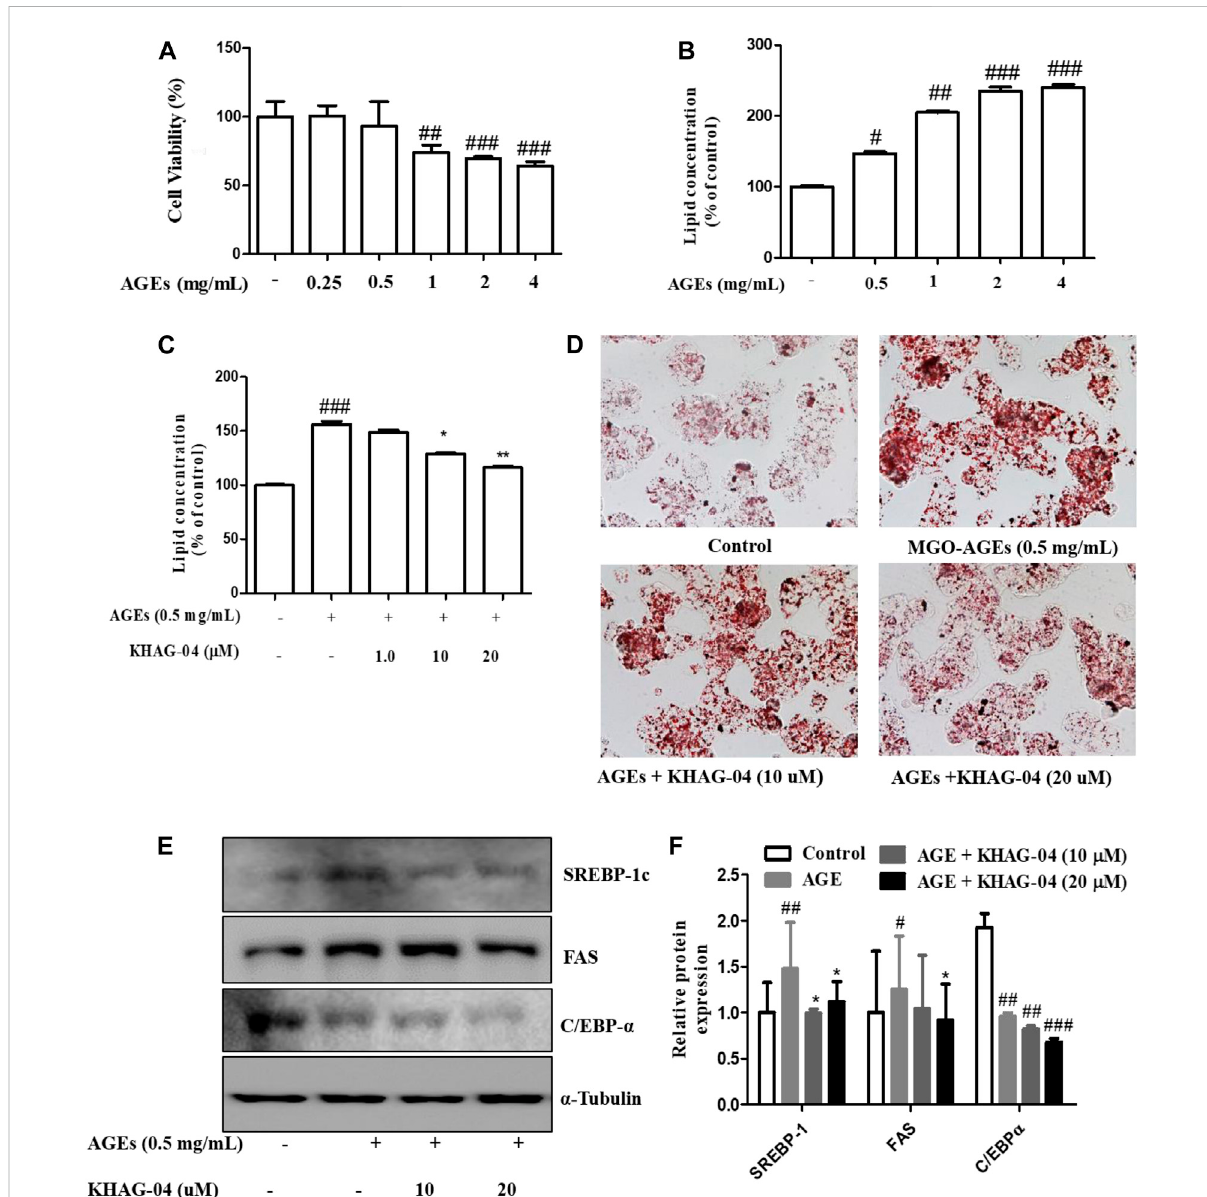
FIGURE 5 EffectsofKHAG-04onAGE-inducedmetabolism – relatedmarkersinHepG2cells. (A) CellviabilityofAGEsinHep-G2cellswasevaluatedusing theMTTassay. (B) IntracellularlipidconcentrationsinpresenceofadifferentconcentrationofAGEswerequanti fi edbythespectrometerat540 nm. (C,D) HepG2 cells were pretreated with 10 and 20 μ M of KHAG-04 for 1 h and then stimulated with AGEs (0.5 mg/ml) for 23 h. AGE-induced lipid droplet accumulation was observed using oil red o staining (×100 magni fi cation). Intracellular lipid concentrations were quanti fi ed by the spectrometer at 540 nm (E) KHAG-04 inhibited AGE-induced protein expression of SREBP-1c, FAS, and C/EBP- α . A Western blot analysis was performed using the indicated antibodies. (F) Densitometry graph of fi gure (E) . All data are indicated as mean ± SEM ( # p < 0.005 vs Control, ### p < 0.001 vs Control, and * p < 0.05 and ** p < 0.001 vs 0.5 mg/ml